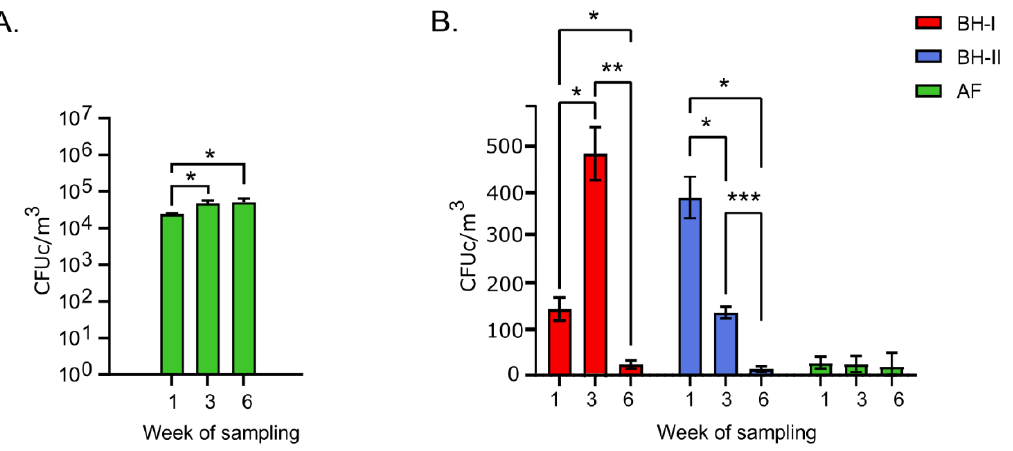
Figure 2. Colony counts of viable microorganisms. ( A ) PCA CFUc/m 3 per week in experimental animal facility ( n = 3). ( B ) MacConkey CFUc/m 3 per week in tunnel-ventilated broiler houses and experimental animal facility ( n = 3). Error bars depict standard deviations. Differences between week of sampling per facility were analyzed by ANOVA and Tukey’s post hoc. Asterisks (*) indicate significant differences with * p < 0.05, ** p < 0.005, *** p < 0.0005. AF: experimental animal facility, BH: broiler house.